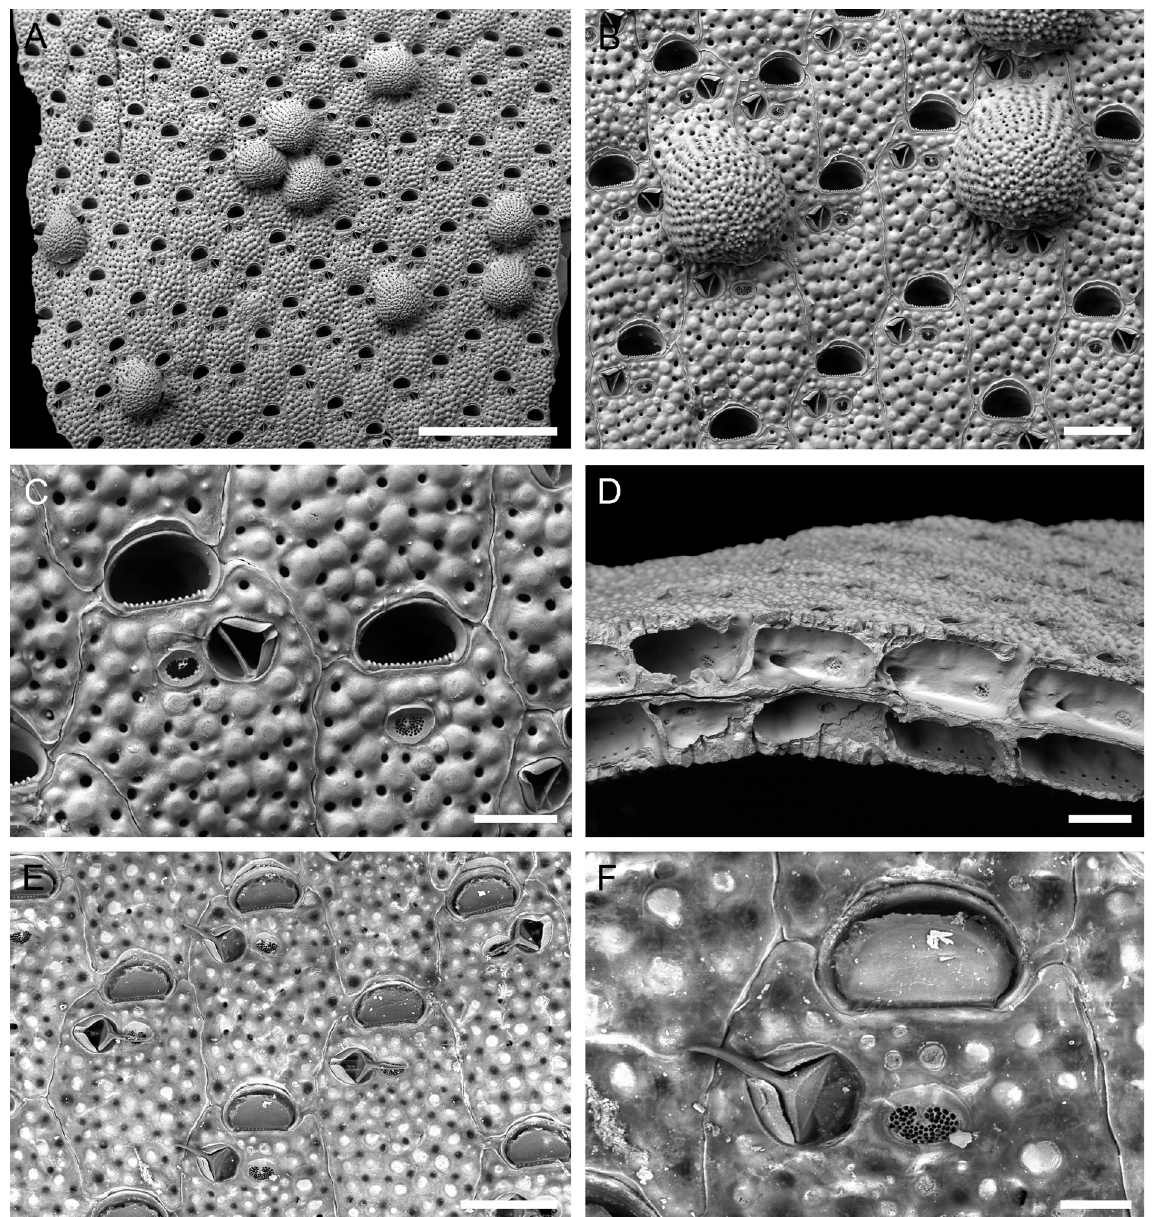
Fig. 7. Microporella ordo Brown, 1952, Recent, Spirits Bay, New Zealand. A–C . NIWA 144880. A . General view of a branch fragment. B . Group of ovicellate and non-ovicellate zooids. C . Close-up of two autozooids, that on the right with preserved filigree sieve plate. D . NIWA 144881, transversal view of the bifoliate branch showing multiporous septula. E–F . NIWA 144882. E . Group of unbleached autozooids showing opercula and thin, pointed avicularian mandibles. F . Close-up of the ascopore and the avicularian mandible. Scale bars: A = 1 mm; B, D–E = 200 µm; C = 100 µm; F = 50